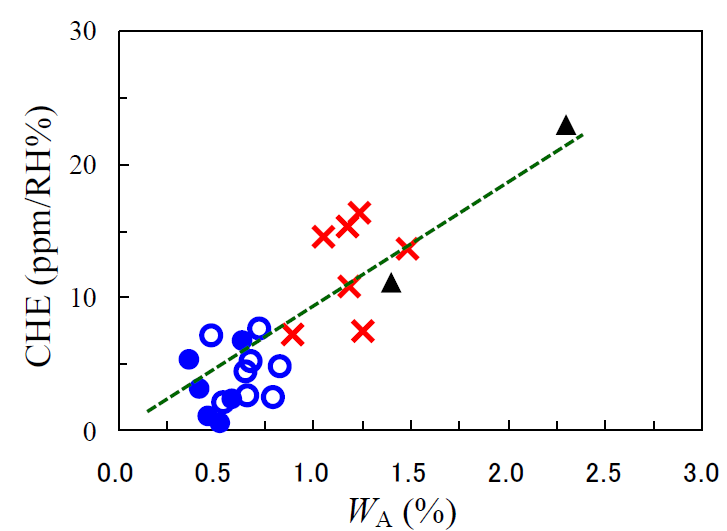
Figure 10. Correlation of the CHE and W A for PEsI or PI films: (●) homo PEsIs developed in this work,